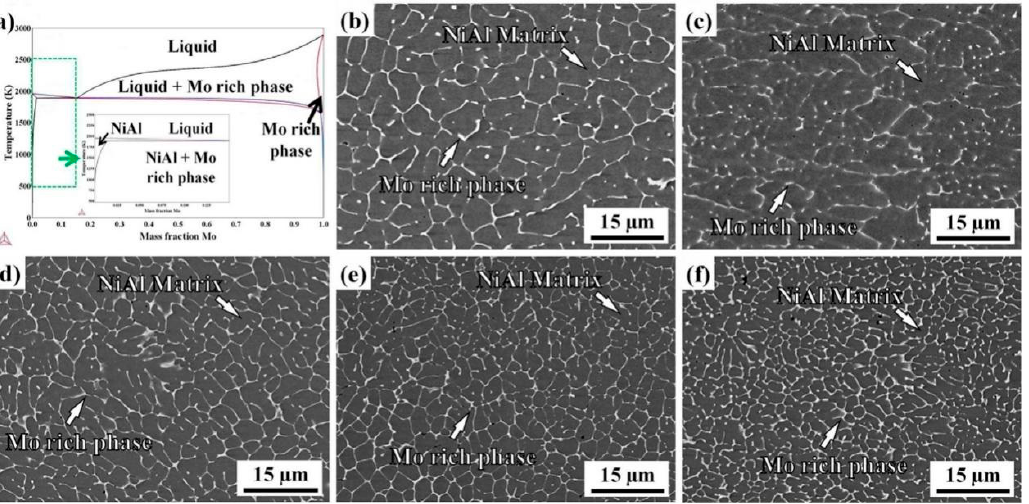
Figure 3. ( a ) Simulated phase diagram of NiAl with different amounts of Mo addition. Backscatter SEM micrographs of NiAl coatings with: ( b ) 3 wt.%, ( c ) 6 wt.%, ( d ) 9 wt.%, ( e ) 12 wt.%, and ( f ) 15 wt.% Mo addition.